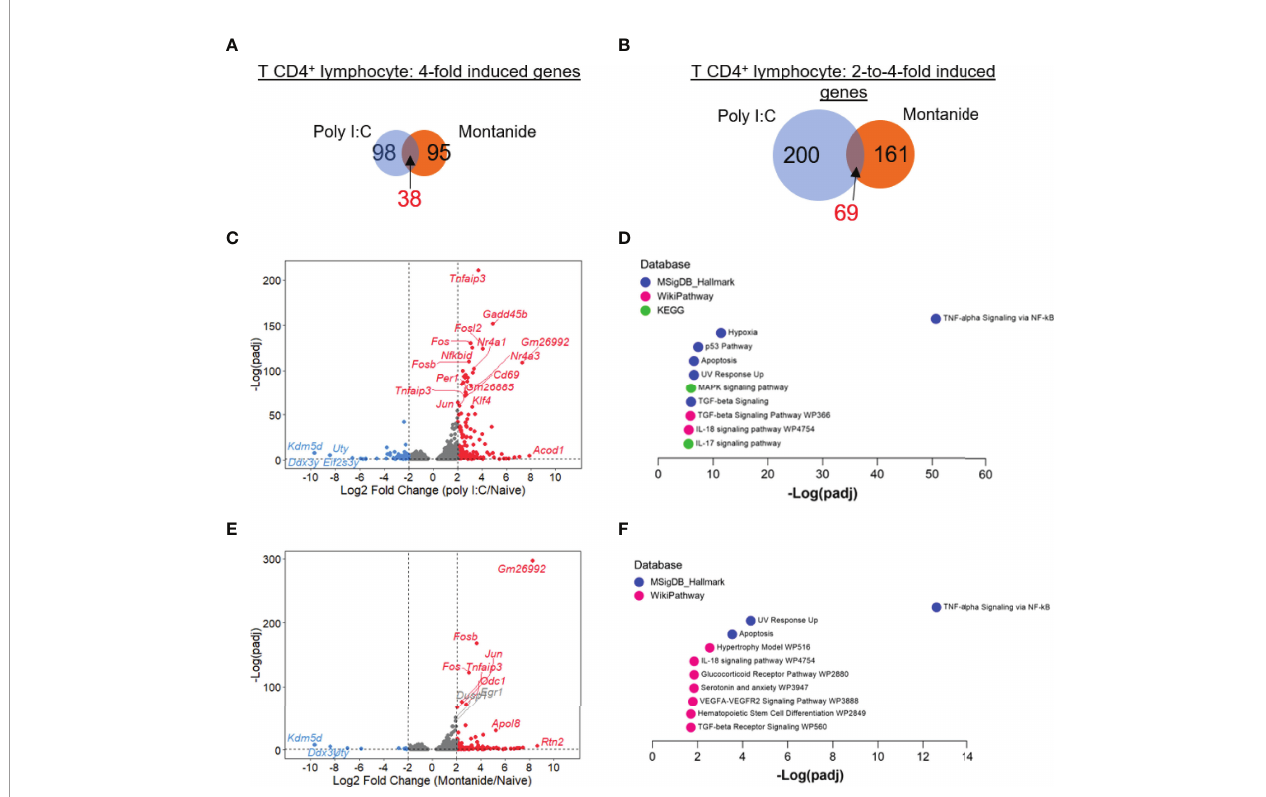
FIGURE 4 | Poly (I:C) and Montanide ISA 720 induced almost the same number of DEGs in T CD4 + lymphocytes, although speci fi c gene signatures were more signi fi cantly detected in Poly (I:C)-adjuvanted mice. Differentially expressed genes (DEGs) were determined with the R-Bioconductor DESeq2 package, using the raw reads from the different samples as input. Genes that displayed a p-adjusted < 0.05 were considered for downstream analysis. (A, B) , Venn diagrams depicting DEGs detected only in Poly (I: C)-adjuvanted, only in Montanide-adjuvanted or in both groups of mice. (C) , volcano plot highlighting the Poly (I:C)-induced DEGs. (D) , gene enrichment analysis of the 4-fold- induced genes by Poly (I:C), performed with the Enrichr webtool. (E) , volcano plot highlighting the Montanide-induced DEGs. (F) , gene enrichment analysis of the 4-fold- induced genes by Montanide ISA 720, performed with the Enrichr